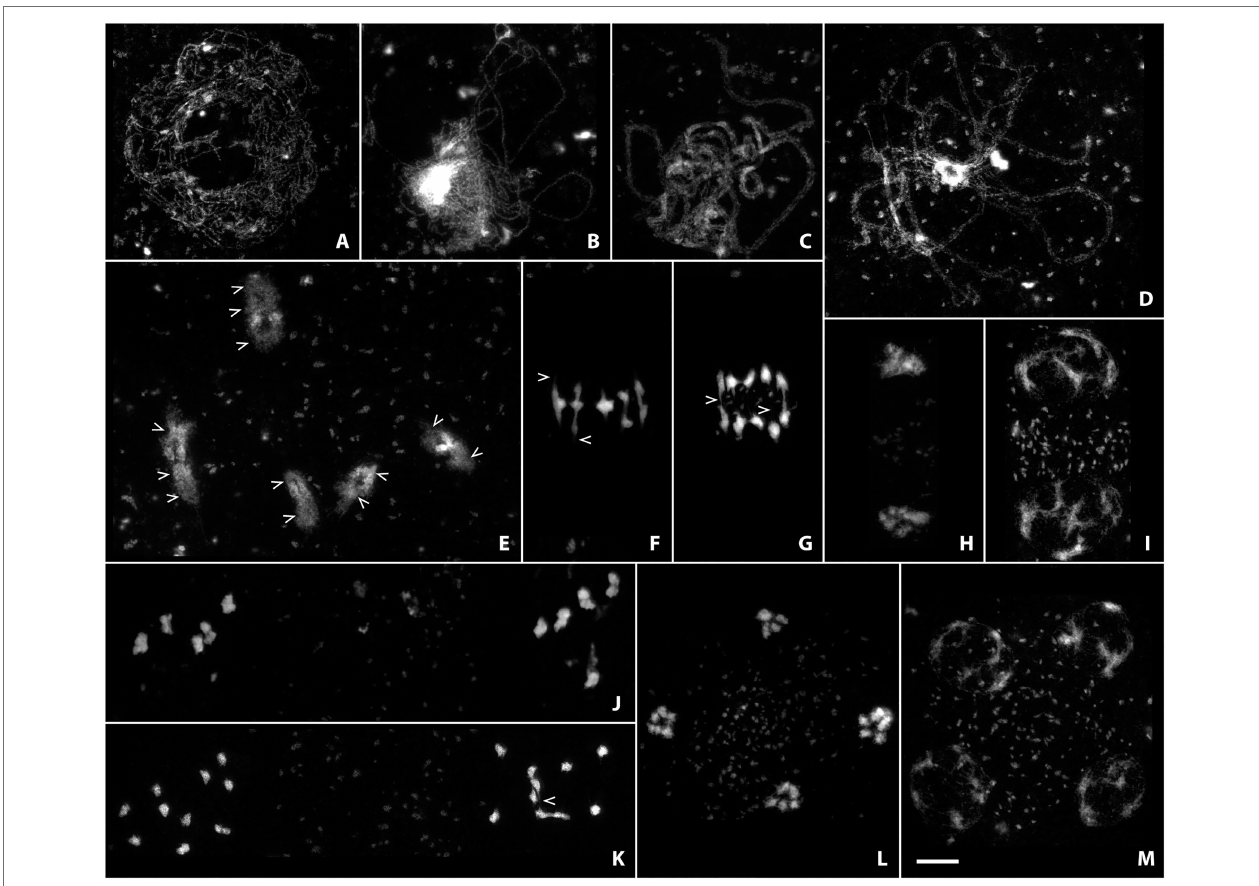
FIGURE 3 | Acid-spread nuclei from pollen mother cells depicting the meiotic progression in wild-type male meiocytes in super-resolution. Chromatin was stained with SiR DNA and imaged with a stimulated emission depletion (STED) nanoscope. The meiotic stages are: (A) Leptotene; (B) Zygotene; (C) Pachytene; (D) Diplotene; (E) Diakinesis; (F) Metaphase I; (G) Anaphase I; (H) Telophase I; (I) Dyad; (J) Metaphase II; (K) Anaphase II; (L) Telophase II; (M) Tetrad. Scale Bar: 5 μ